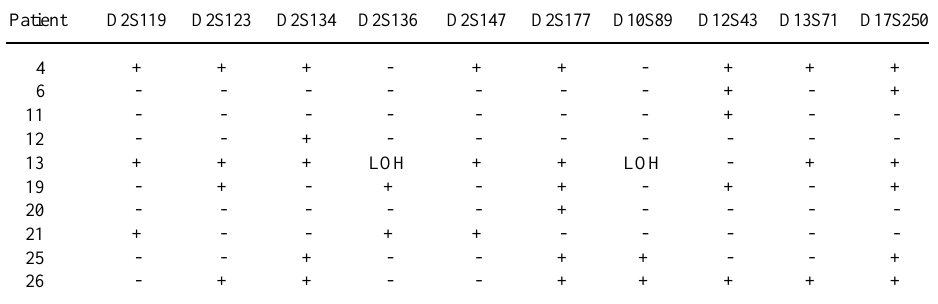
Table I - MSI in primary gastric